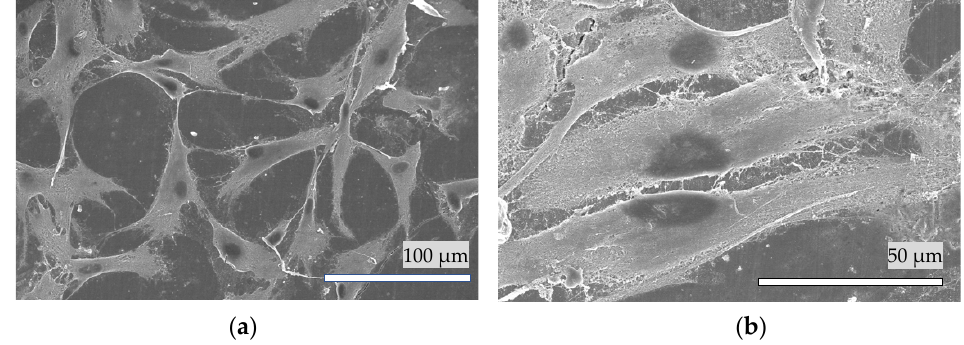
Figure 10. A typical SEM image of the HPdLF cells attached on the surface of ( a ) the hydroxyapatite coating and ( b ) bovine enamel.